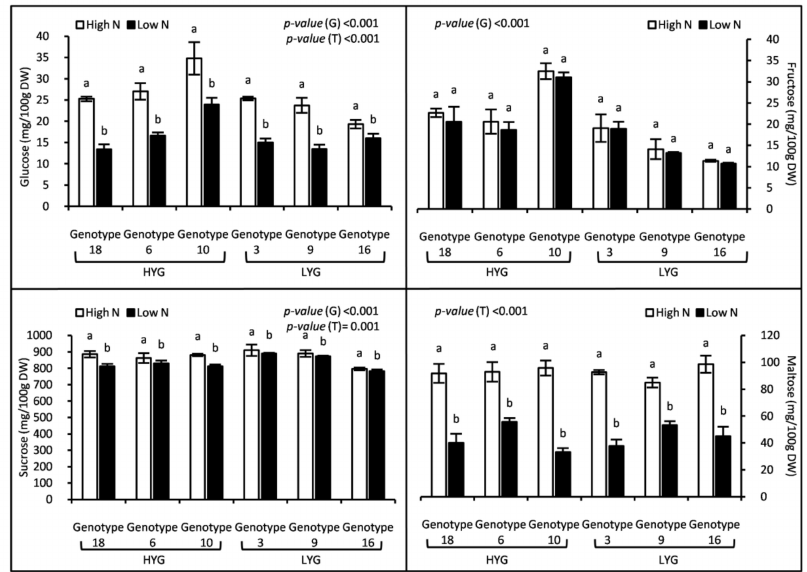
Figure 1. Grain soluble sugars concentrations of 6 wheat genotypes fertilized by two nitrogen levels (High and Low). Data correspond to the means ± standard error (n = 4). For each genotype, letters indicate significant di ff erences between the two treatment. At p < 0.5. p -values corresponds to two-way ANOVA analysis. HYG: High-yielding genotypes, LYG: Low-yielding genotypes, G: Genotype, T: Treatment.